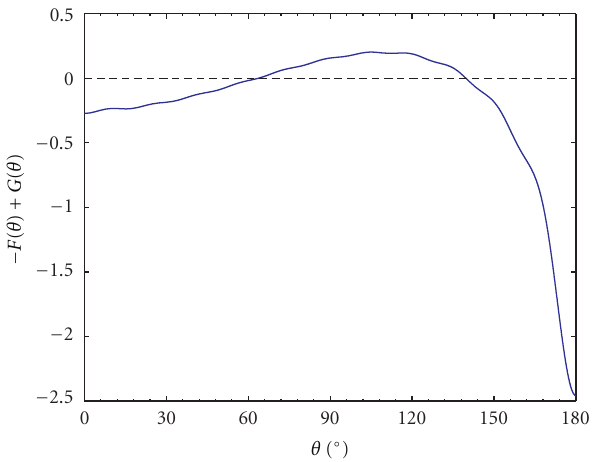
Figure 21: The e ff ect of the odd multipole preference on the corre- lation.